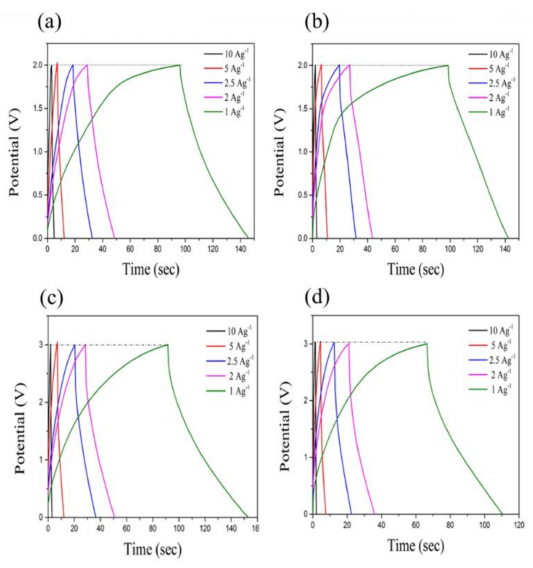
Figure 9. Galvanic charge–discharge curves of ( a ) MBIB; ( b ) PIL-M-(Br); ( c ) MBIT; and ( d ) PIL-M-(Br)-based supercapacitors at different current densities.